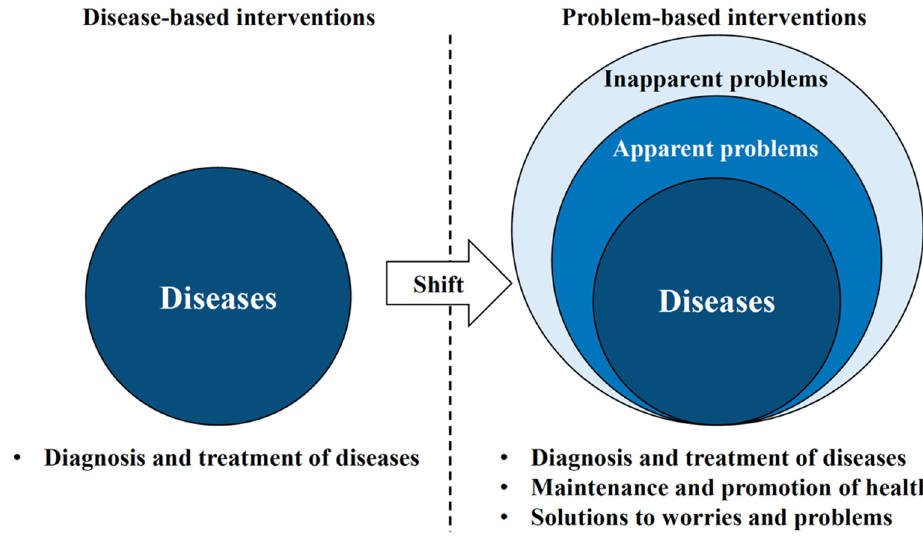
Figure 3. Oral health management is a paradigm shift in oral health care .